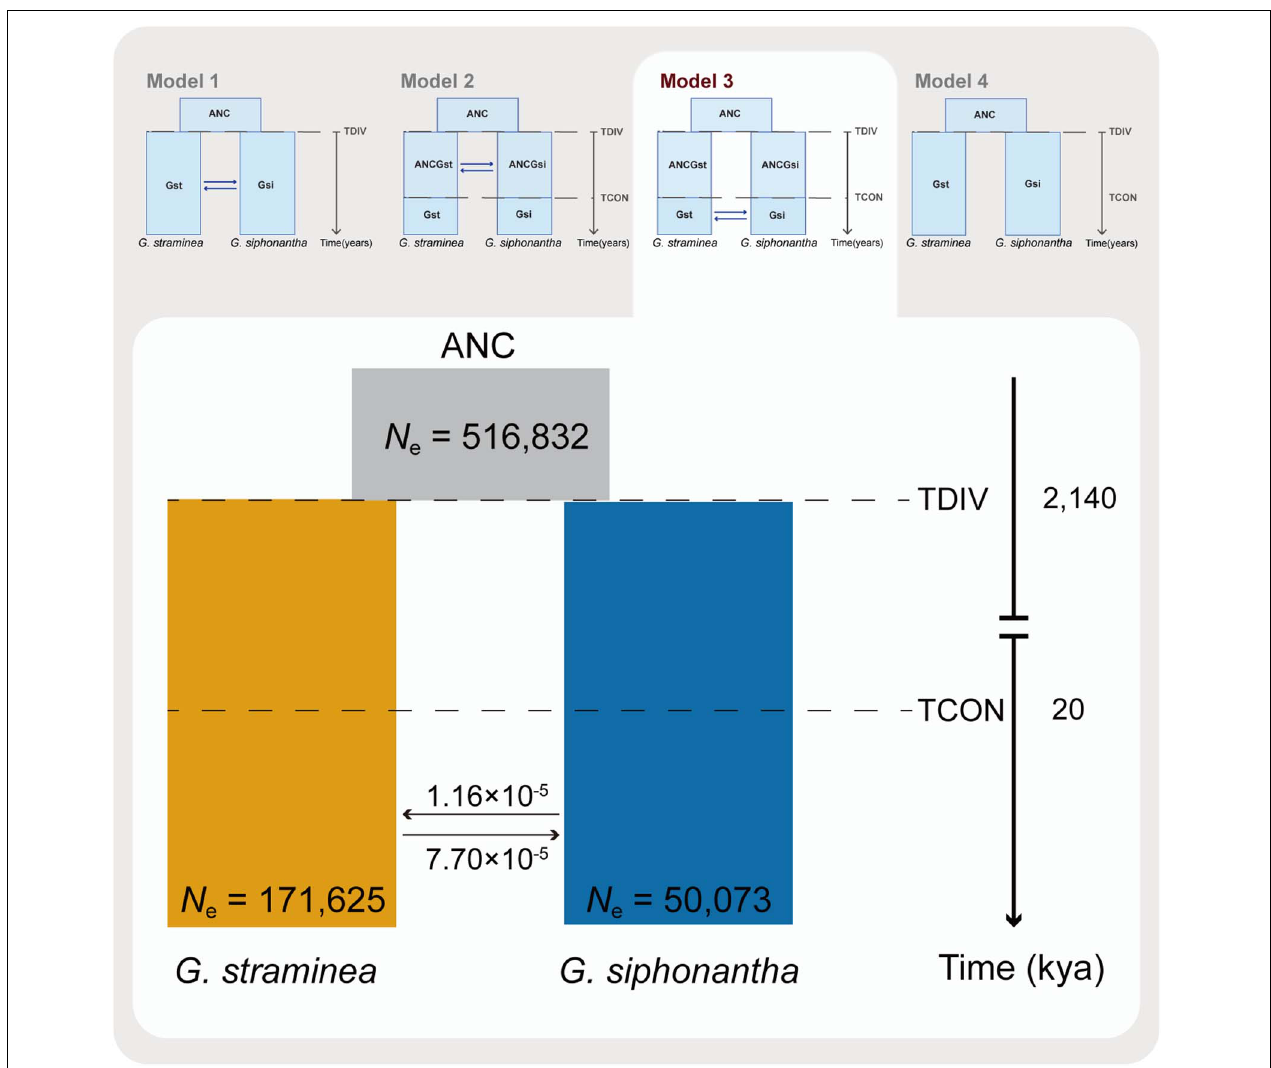
FIGURE 4 | Schematic of demographic history of Gentiana siphonantha and G. straminea. Graphic summary of the models (i.e., model 1: there has been continuous gene flow since TDIV; model 2: there had been gene flow between the two species from TDIV to TCON; model 3: there has been gene flow from TCON to present; Model 4: there has been no gene flow between the two species since TDIV) explored were shown in the upper part, where ANC denotes the ancestor of the two species, TDIV means the time of divergence between the two species, TCON stands for a specific time in the past when there was gene flow between the two species. The best-fitting model was shown in detail in the lower part of the photo, where the values close to arrows indicate migration rate per generation and both the divergence times and estimated population size are also